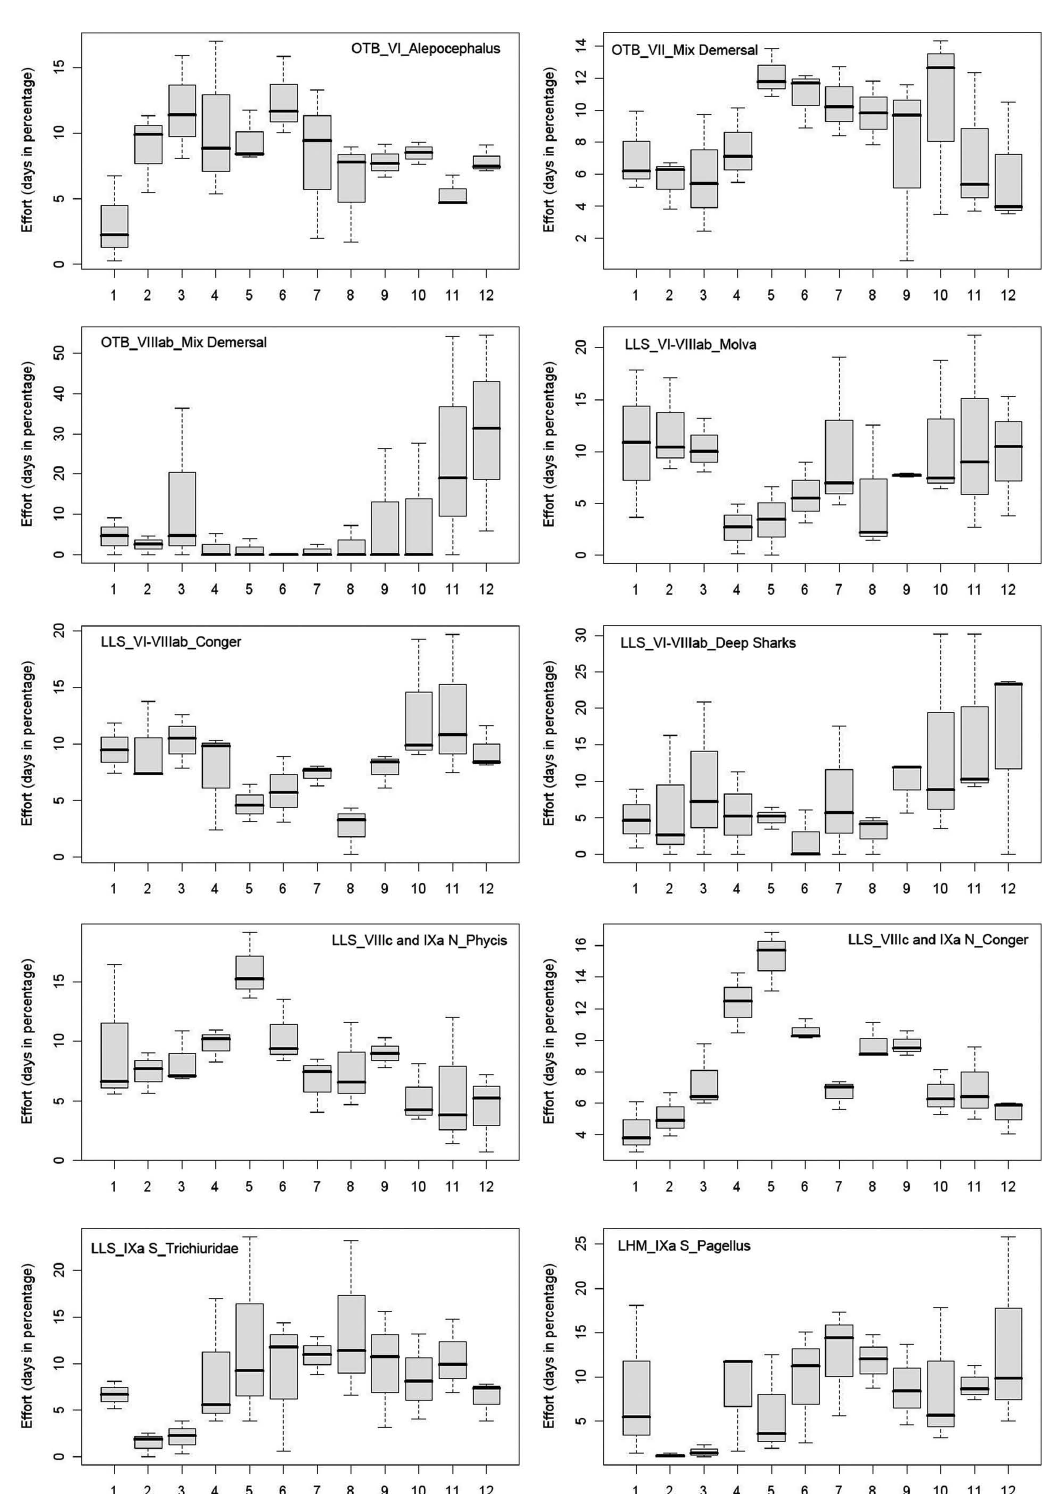
Fig . 4. – Seasonality of the effort by fishing tactics (by row and from top to bottom): Otter trawl targeting Alepocephalus baiirdi in VI ICES Division. Otter trawl targeting M. merluccius in VII. Otter trawl targeting M. merluccius in VIIIabde. Longlines targeting Molva in VI. VII and VIIIabde. Longlines targeting Conger conger in VI, VII and VIIIabde. Longlines targeting deep sharks in VI, VII and VIIIabde. Longlines targeting Phycis blennoides in VIIIc and IXa North. Longlines targeting Conger conger in VIIIc and IXa North. Longlines targeting Trichiu- ridae in IXa South and handlines targeting Pagellus bogaraveo in IXa